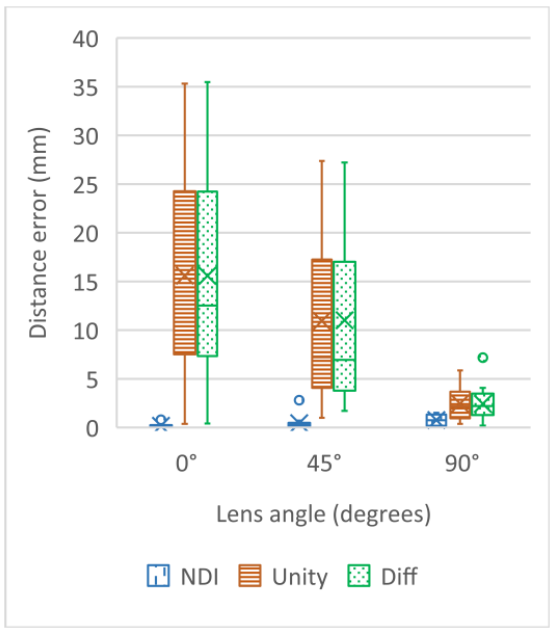
Figure 4. Mean and standard deviation of distance error (mm).